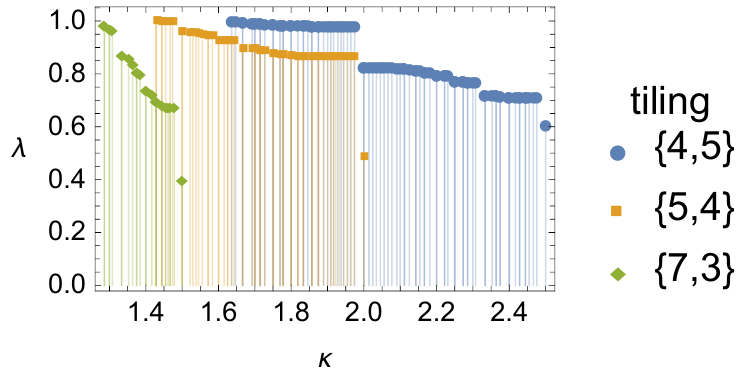
Figure 10 . (cid:21) as a function of (cid:20) in di(cid:11)erent tilings, where only some rational numbers of (cid:20) 2 ( (cid:20) h ; (cid:20) 0 ] are